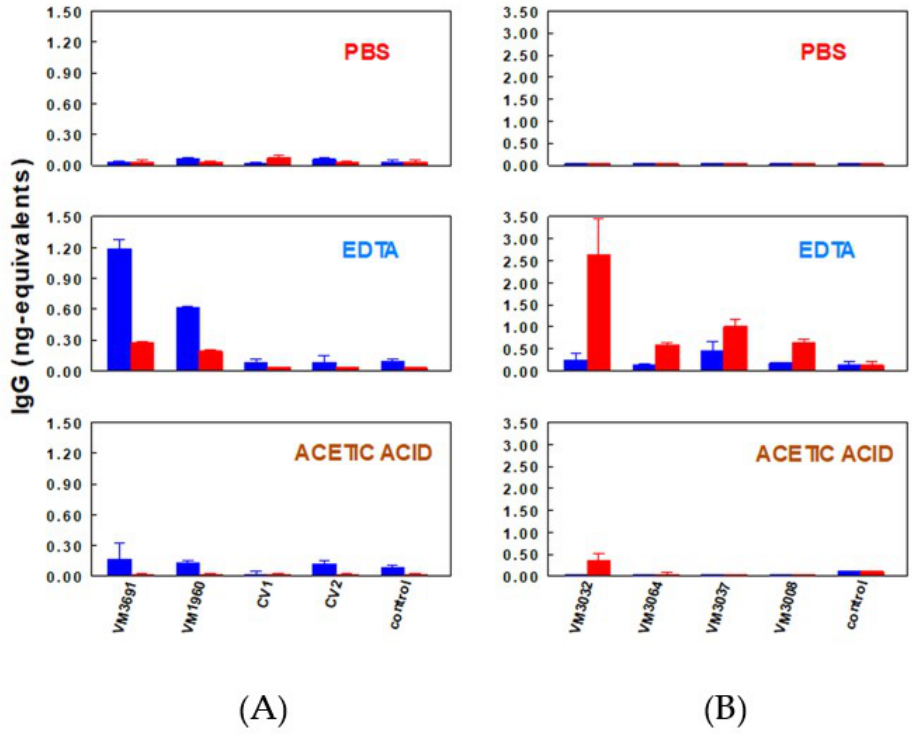
Figure 6. Quantities of human IgG (blue bars) and horse IgG (red bars) detected in PBS, EDTA and acetic acid extracts of ( A ) hominin and ( B ) equid fossils from Venta Micena, determined with quantitative dot-blotting. The extraction solutions were used as negative controls. From Torres et al. [51], with permission.